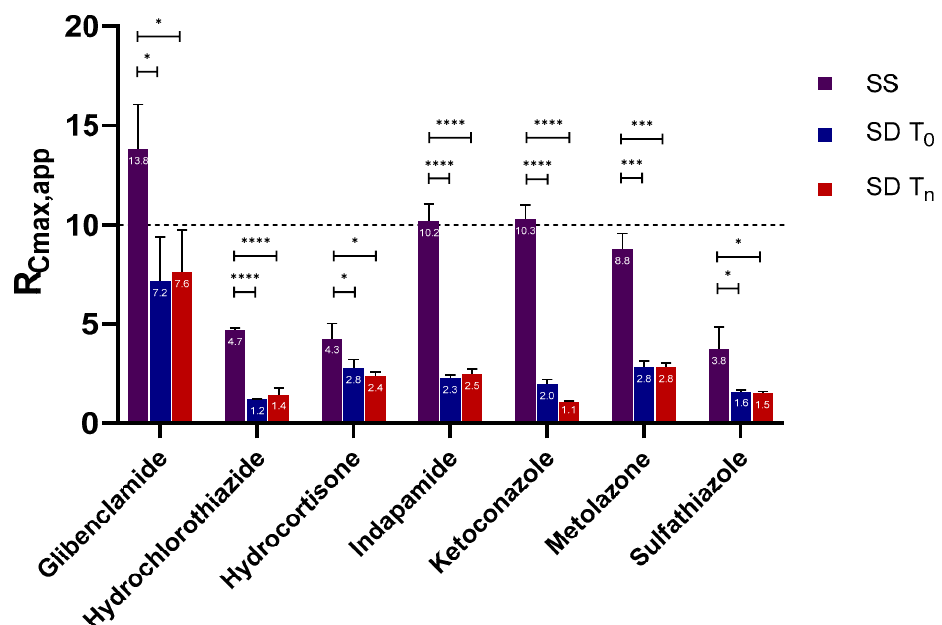
Figure 5. The apparent C max,app ratio (R Cmax , app ) of the solvent shift for fresh and aged and/or crystalline spray-dried APIs at tenfold supersaturation ratios. The solvent shift is represented as SS, the freshly spray-dried samples as SD T 0 , and the crystallized and/or aged samples as SD T n , since each of the APIs crystallized at different time points (see Table 1). At a 95% confidence interval, a p- value of <0.05 is considered statistically significant. The mean ± standard deviation values of three replicates are shown. The following statistics are described: p < 0.05 is denoted *, p < 0.001 is denoted ***, p < 0.0001 is deonted ****.